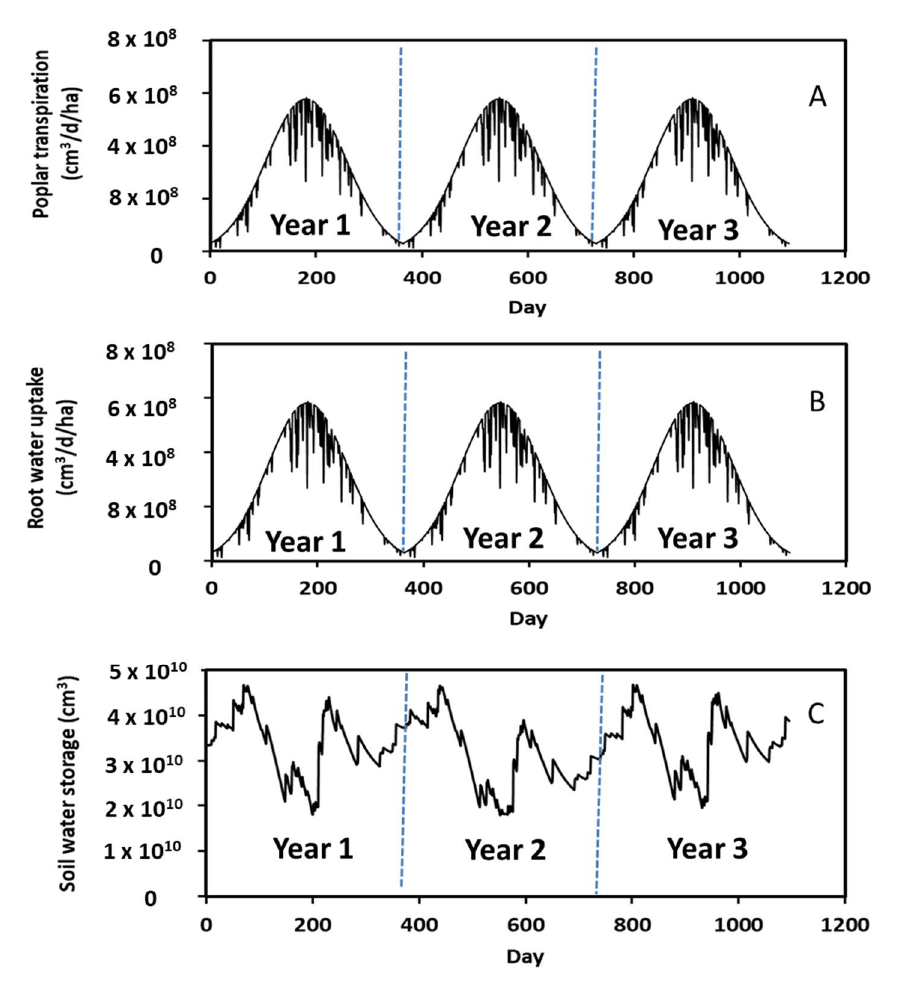
Figure 6. Simulated daily leaf transpiration, root water uptake, and soil water storage during the 3-year period.